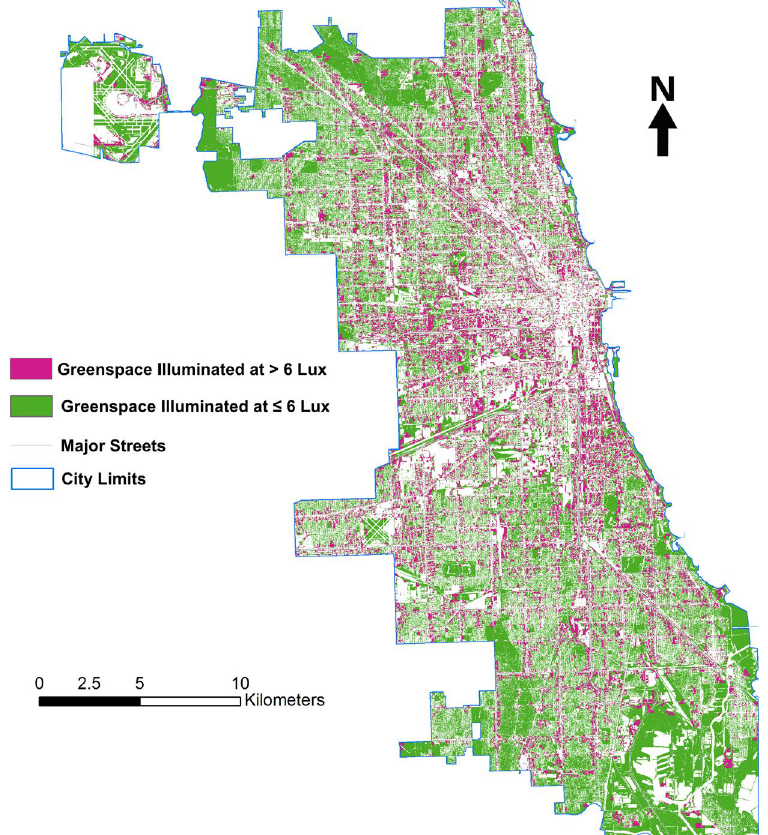
Figure 4. Behaviorally relevant levels of photopollution are found across the city and many smaller greenspace patches are completely affected by behaviorally relevant illumination levels. This map combines data from the city of Chicago showing urban greenspaces with areas estimated to be ≥ 6 lux, based on regression tree models fit on ground-level control points using ISS imagery.